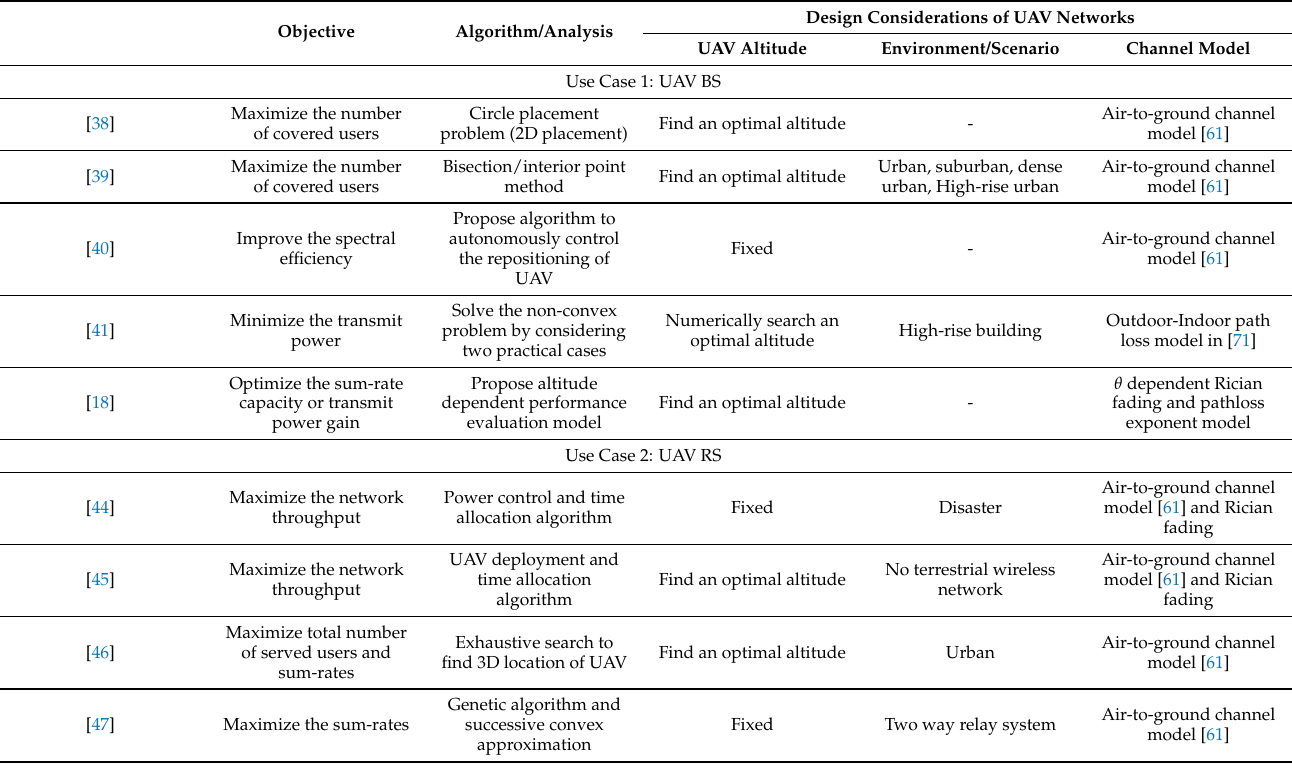
Table 2. Deployment of single UAV.